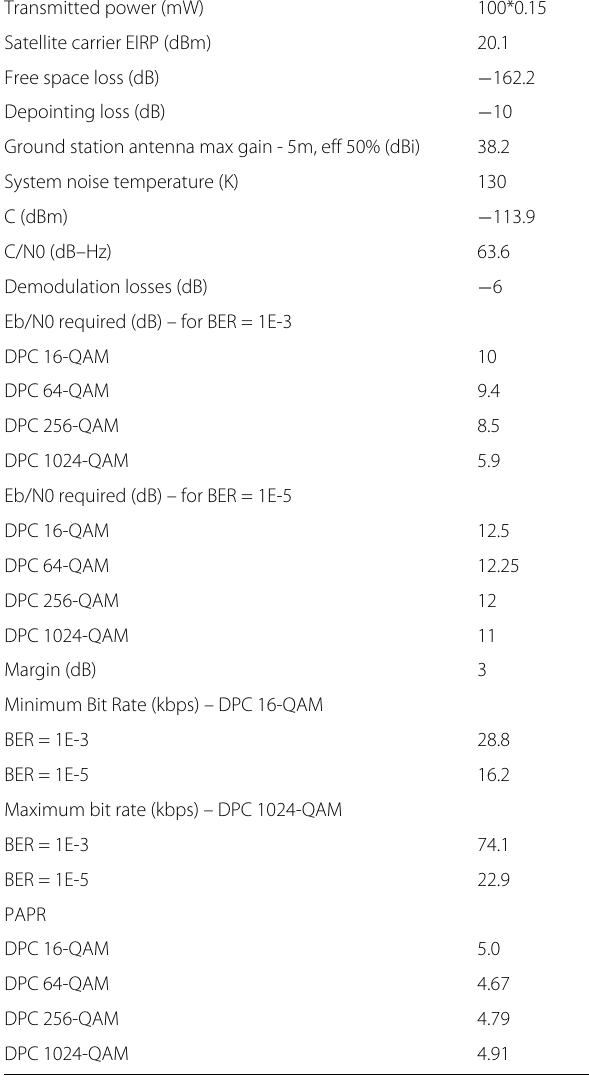
Table 2 Cognitive user link